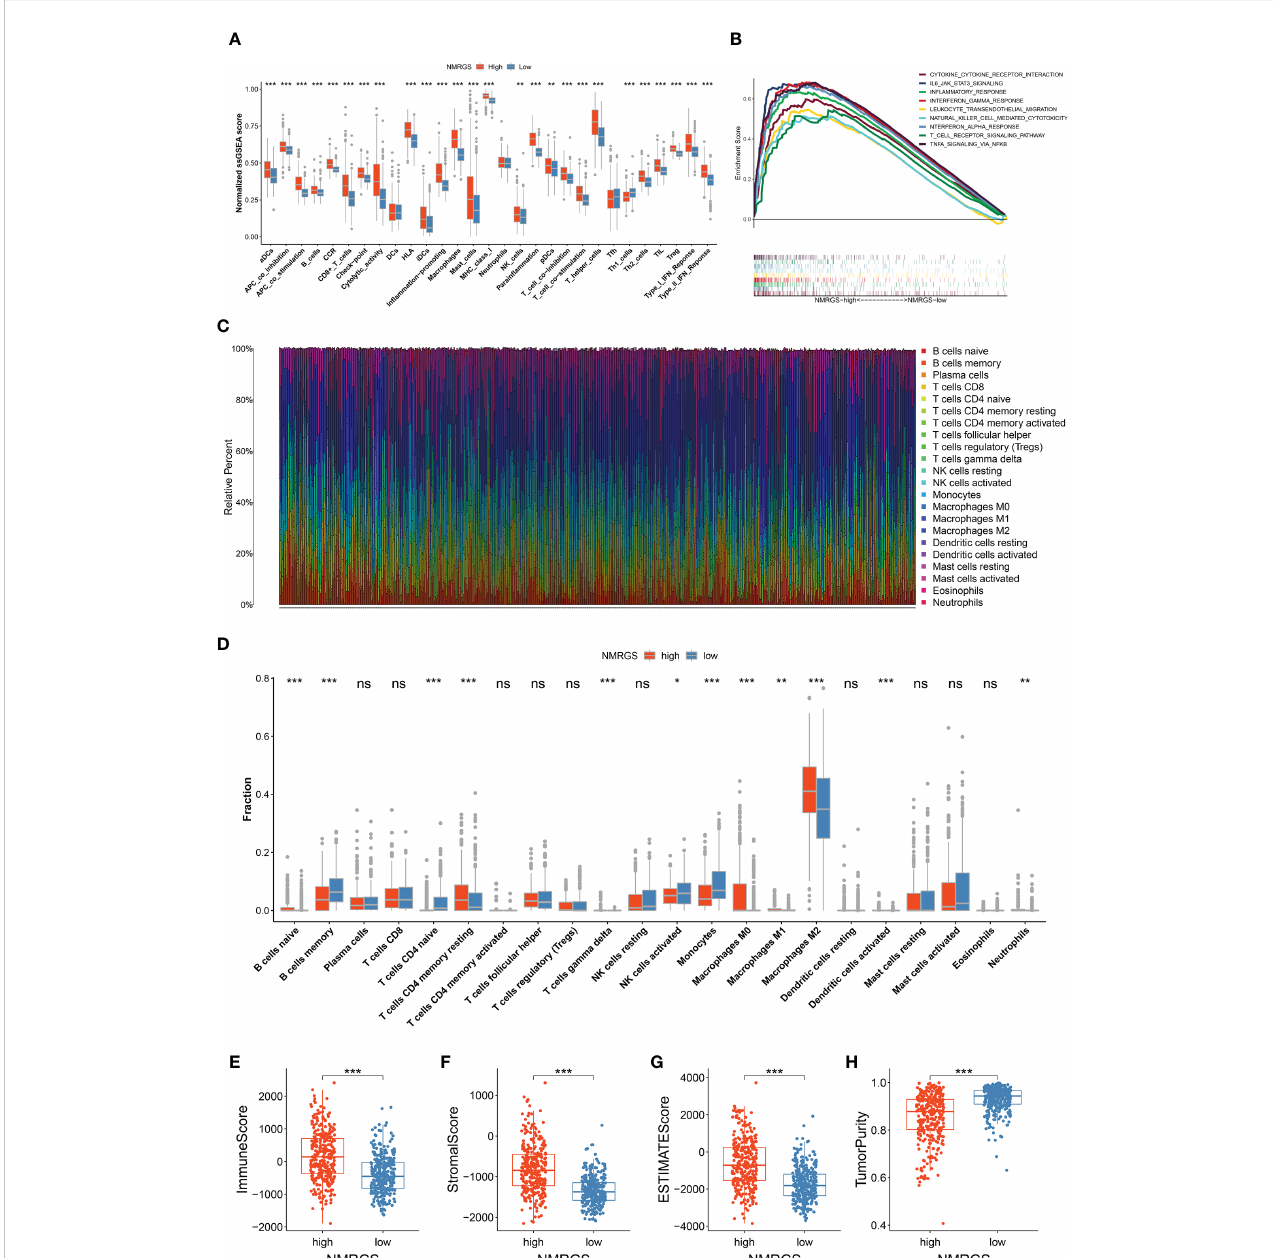
FIGURE 6 Association between NMRGS and immune landscape in glioma. (A) Comparison of ssGSEA scores between NMRGS-low group and NMRGS-high group. (B) GSEA analysis of immune-related pathways between NMRGS-low group and NMRGS-high group. (C) Proportion of the immune cell in fi ltration of glioma samples in CGGA693 cohort. (D) Comparison of immune cell in fi ltration between NMRGS-low group and NMRGS-high group. (E – H) Comparison of ImmuneScore, StromalScore, ESTIMATEScores, and TumorPurity between NMRGS-low group and NMRGS-high group. ns, not signi fi cant; * p < 0.05, ** p < 0.01, *** p <